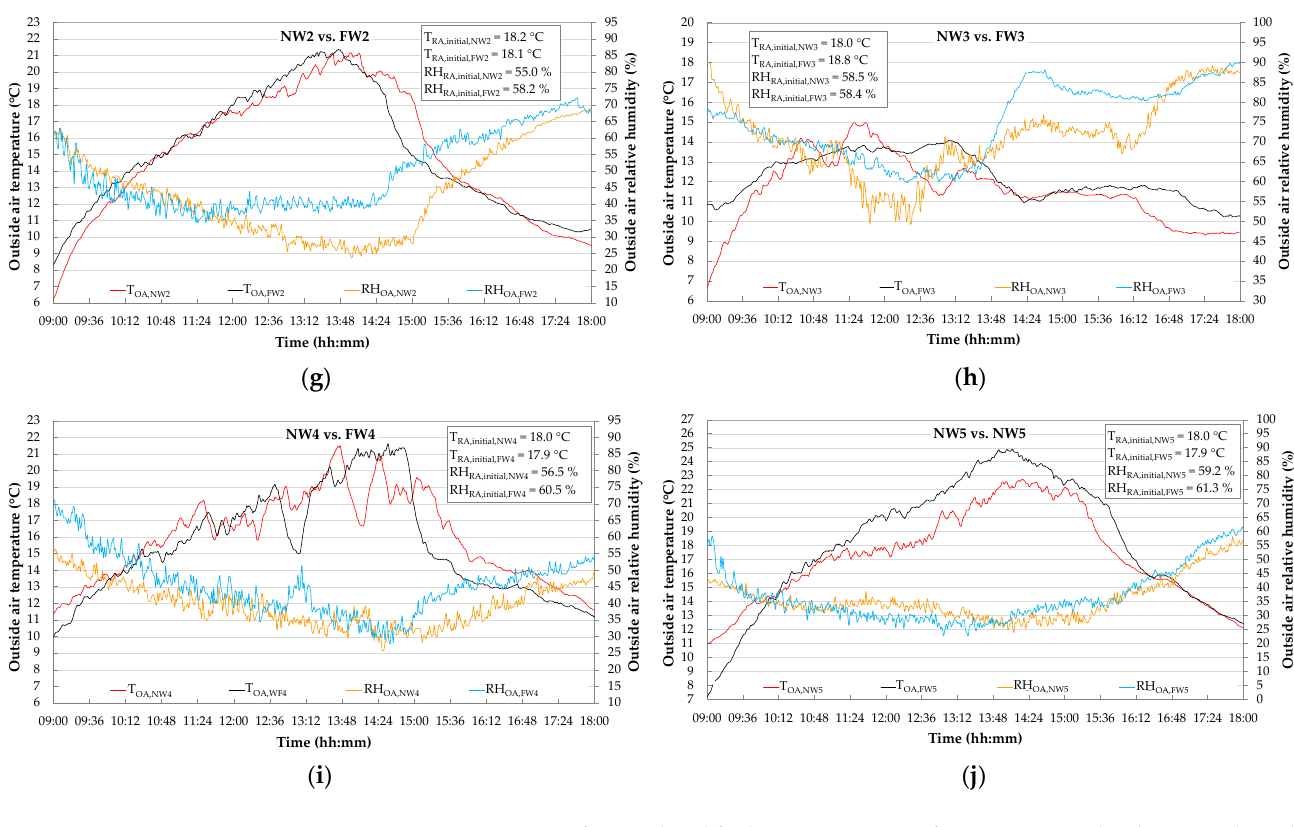
Figure A2. Comparison of normal and faulty tests in terms of T OA , RH OA and indoor initial condi- tions: comparison between NS1 and FS1 ( a ), NS2 and FS2 ( b ), NS2 and FS3 ( c ), NS1 and FS4 ( d ), NS3 and FS5 ( e ), NW1 and FW1 ( f ), NW2 and FW2 ( g ), NW3 and FW3 ( h ), NW4 and FW4 ( i ) and NW5 and FW5 ( j ).